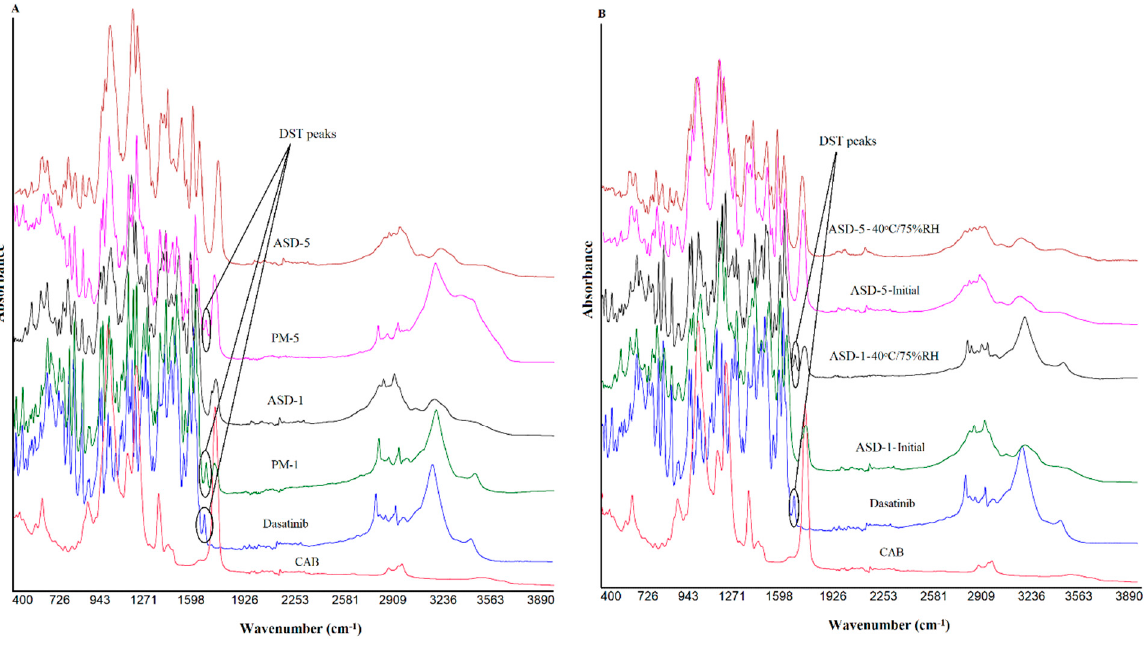
Figure 3. FTIR spectra of ( A ) PM − 1, PM − 5 ( B ) ASD − 1, ASD − 5 initial and 40 °C/75% RH exposed.